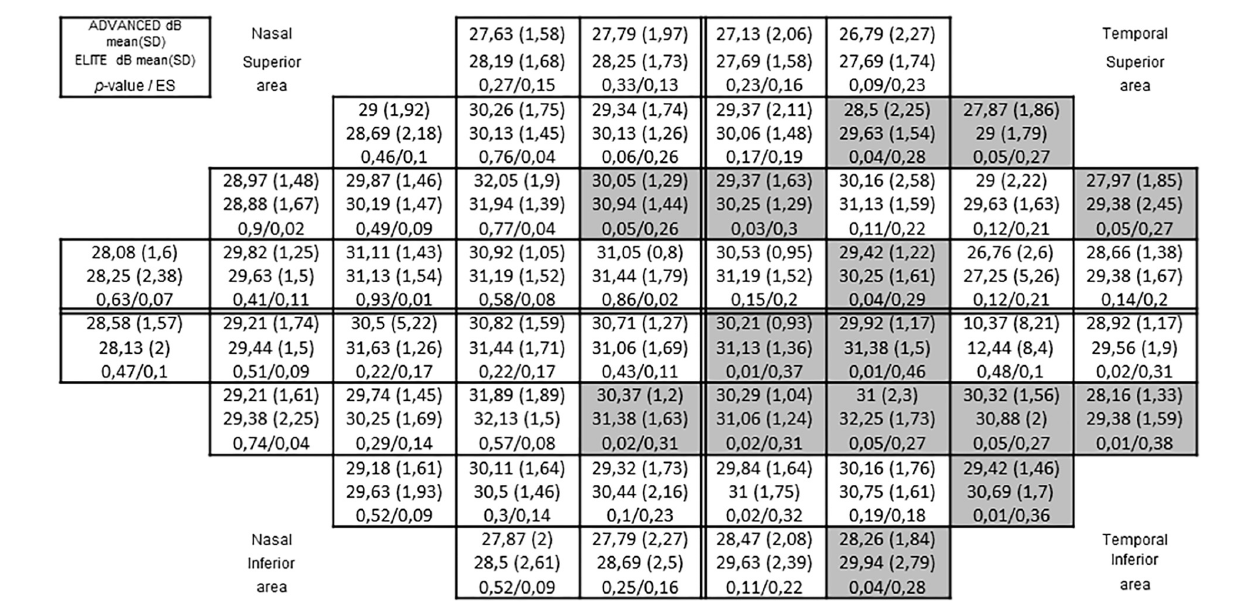
(advanced climbers scored –0.15 logMAR; elite climbers scored – 20 logMAR). They also suggested that these baseball players’ visual acuity may be superior to those in the general